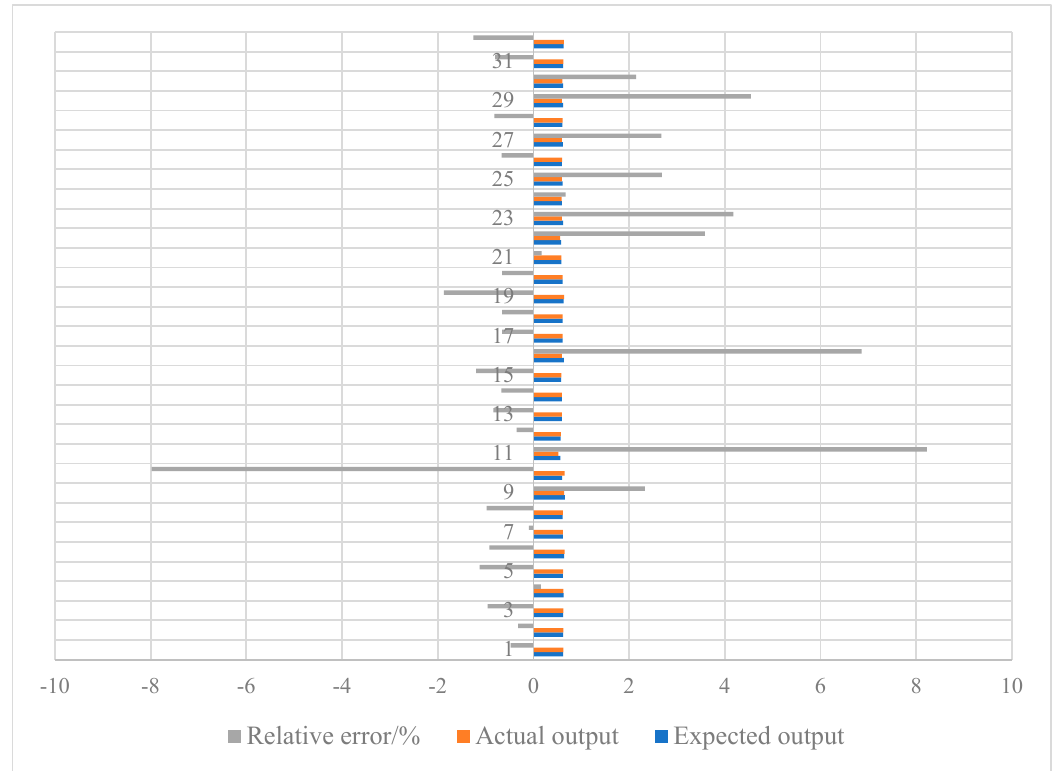
Figure 5. Error analysis for the test set data.